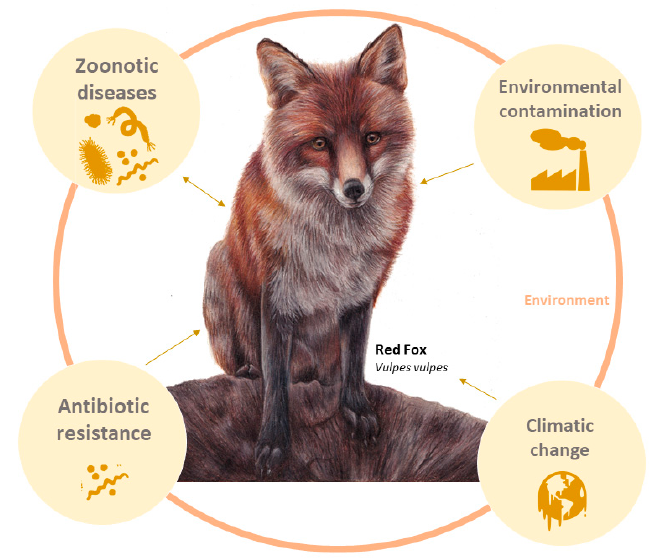
Figure 1. Red fox ( Vulpes vulpes ) as bioindicator sentinel of environmental ecosystem health: zoonotic diseases, environmental contamination, antibiotic resistance, climate changes, and anthropogenic changes.